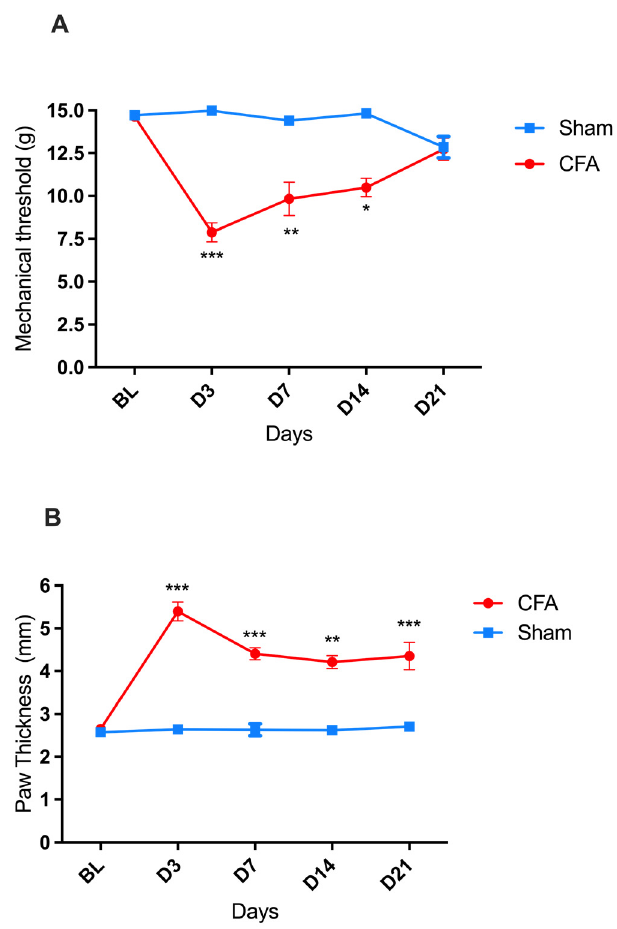
Figure 1. CFA-induced pain (mechanical allodynia) and inflammation (paw edema) in male Wistar rats. ( A ) Progression of mechanical hypersensitivity, measured as mechanical withdrawal response thresholds to von Frey filaments, after intraplantar injection of CFA ( • ; n = 17) or sham paw injury with saline ( (cid:4) ; n = 7). ( B ) Progression of paw edema, measured as the diameter of the left hind paw, after intraplantar injection of CFA ( • ; n = 17) or sham paw injury with saline ( (cid:4) ; n = 7). * p < 0.05, ** p < 0.01, *** p < 0.001. Each point represents mean ± SEM. See main text for